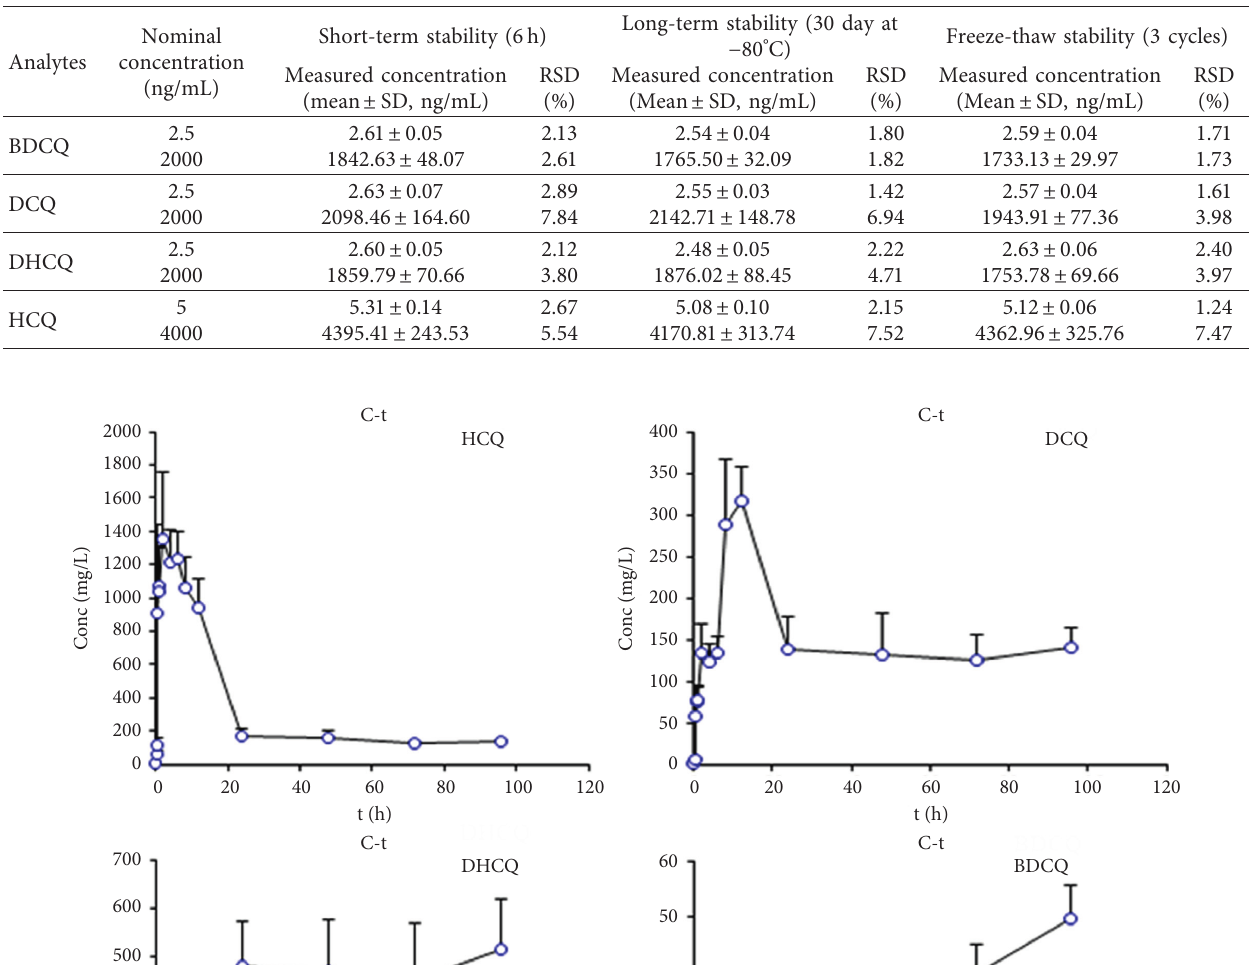
Table 5: Stability of analytes in different conditions ( n � 5).